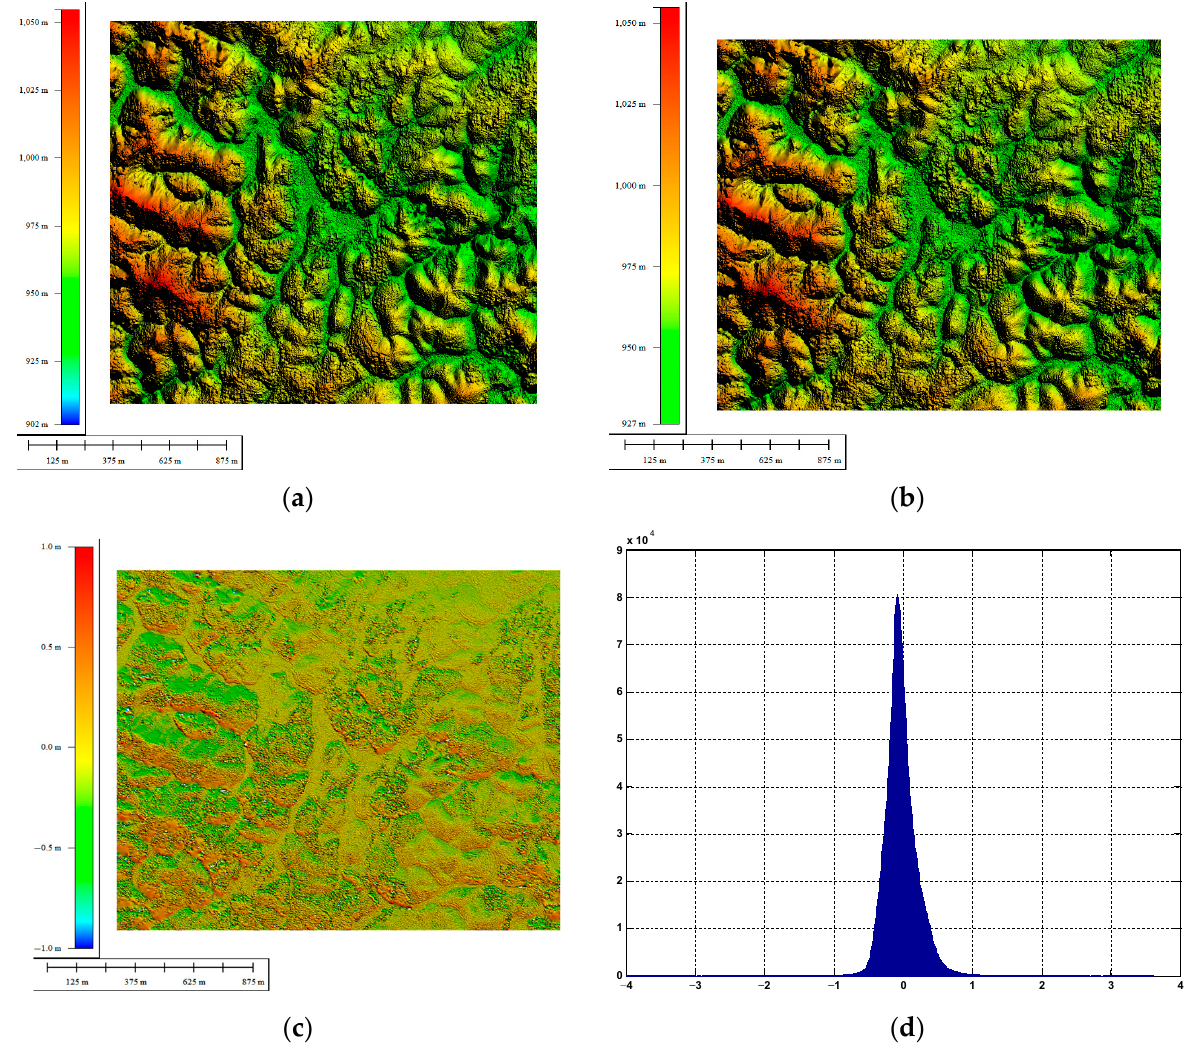
Figure 21. DSM products of strip 5 obtained through elevation inversion, where ( a ) is based on the tie-points, ( b ) is based on marking points and ( c , d ) are the difference and statistical results of two DSMs. Additionally, the abscissa in ( d ) is elevation difference, whose unit is m, and the ordinate in the ( d ) is the number of pixel points corresponding to relative elevation difference.